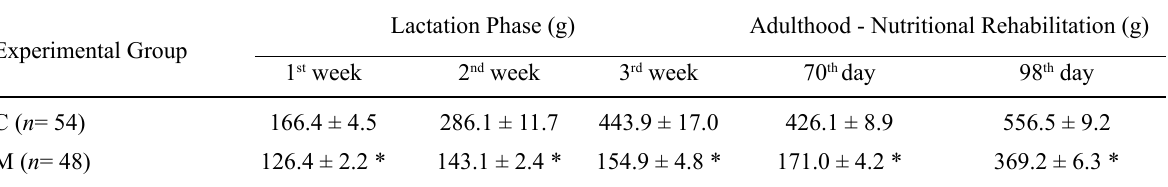
Mean Body Weights of Both Diet Groups, During Nutritional Treatment with Experimental Diets and Nutritional Rehabilitation Experimental